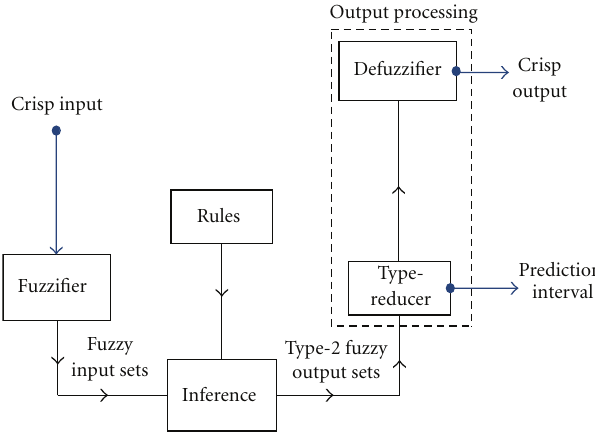
Figure 1: Schematic diagram of type-2 fuzzy logic systems (type-2